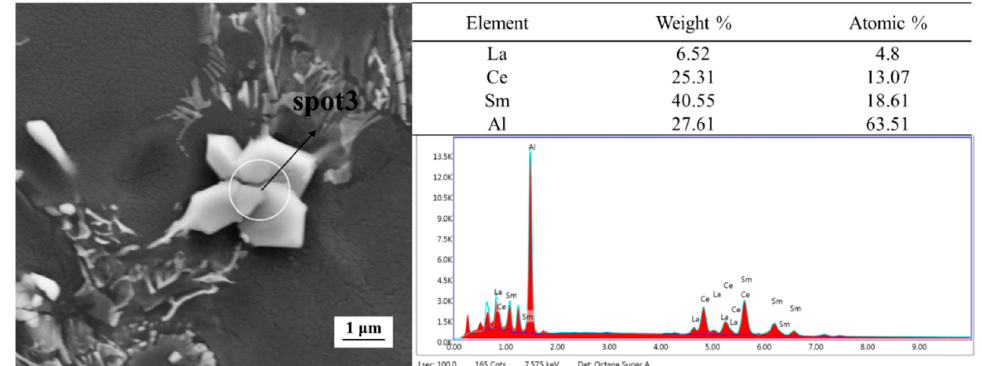
Figure 6. SEM image and the representative point EDS spectrum along with the analysis results of the block phase in the Mg-4Al-4 (La, Ce)-1Sm alloy.